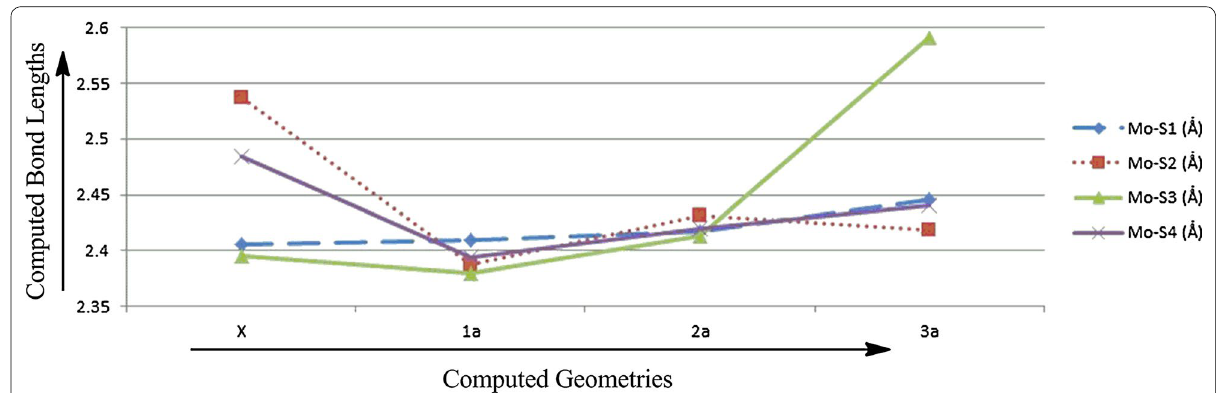
Fig. 7 Plot of crystallographic and computed metal–sulphur bond distances where X represents the experimental data and 1a , 2a , 3a represents the calculated data